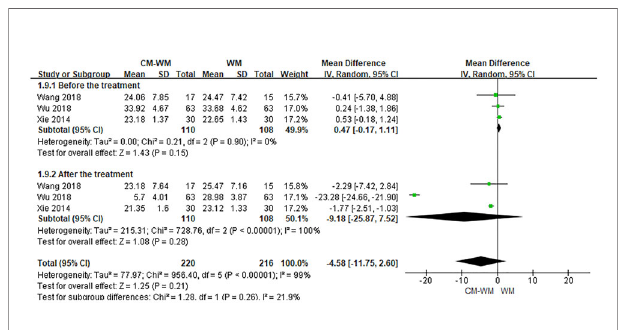
FIGURE 11 | Meta-analyses on CD8.